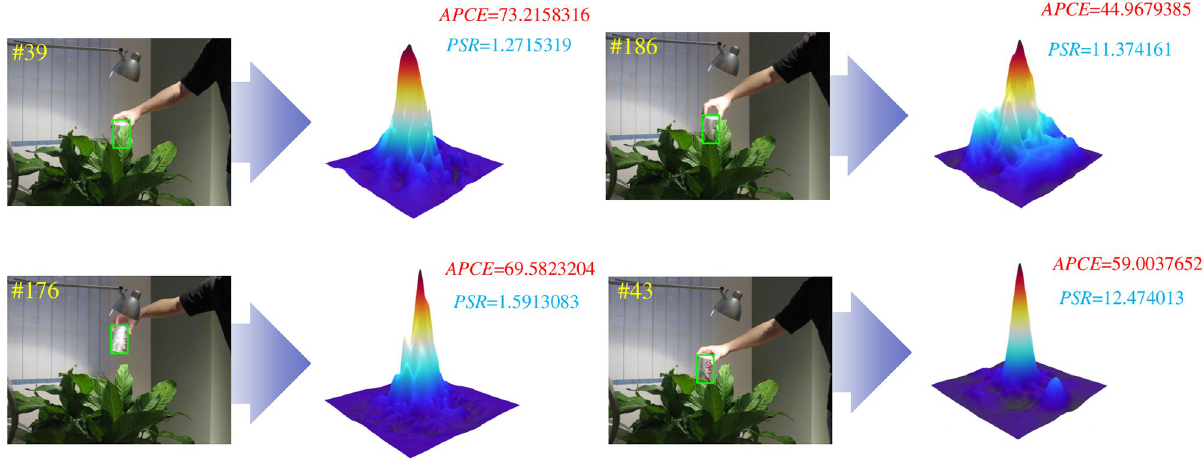
Fig 3. PSR value and APCE value in different tracking